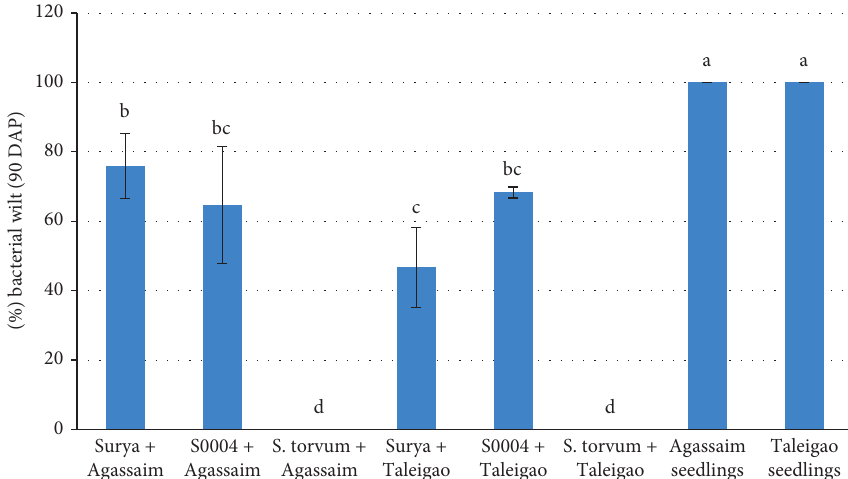
Figure 4: Incidence of bacterial wilt in eggplant grafts on Surya, S0004, and S. torvum ; nongrafted seedlings in the field evaluation at farmers field in Sangolda (Dec 2016). Mean of three replications; each replication consists of 13–16 plants. Treatments are significantly different at 5% (LSD � 14.61) and at 1% (LSD � 20.27) level. Bar in the column represents the standard error. Wilt % in the column indicated by the same letter are not significantly different at 5% level.